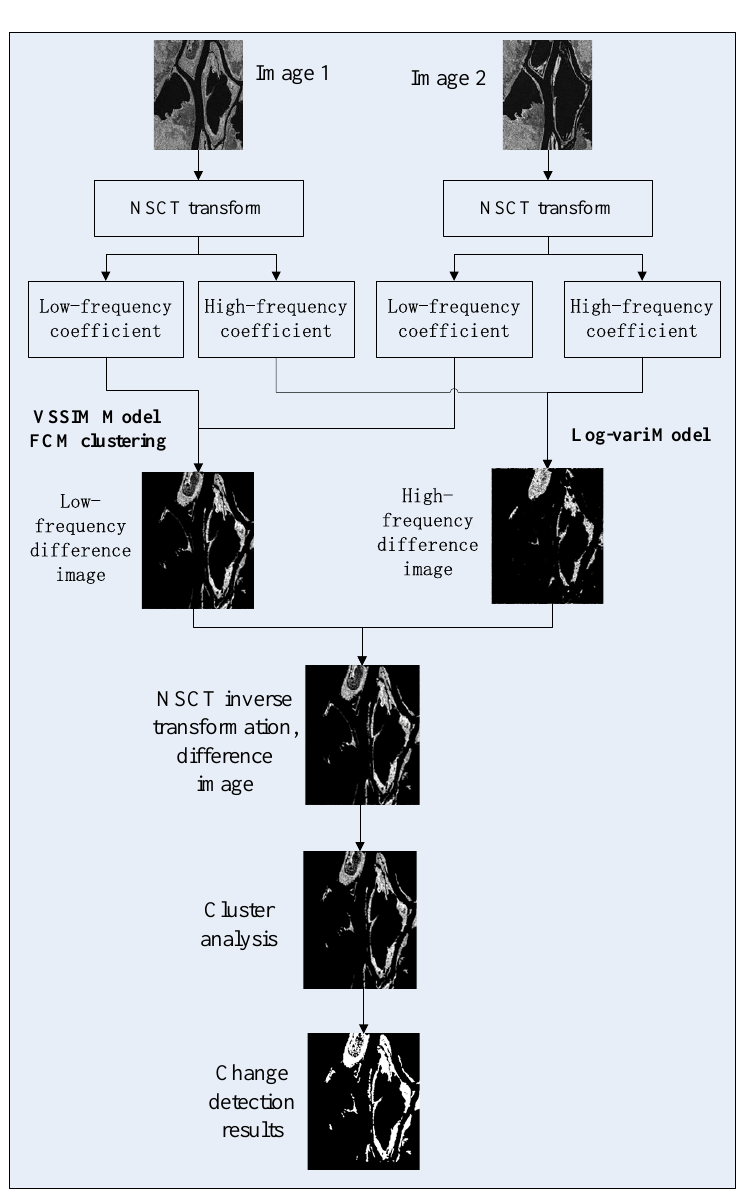
Figure 1. The flow chart of L-V-NSCT change detection.